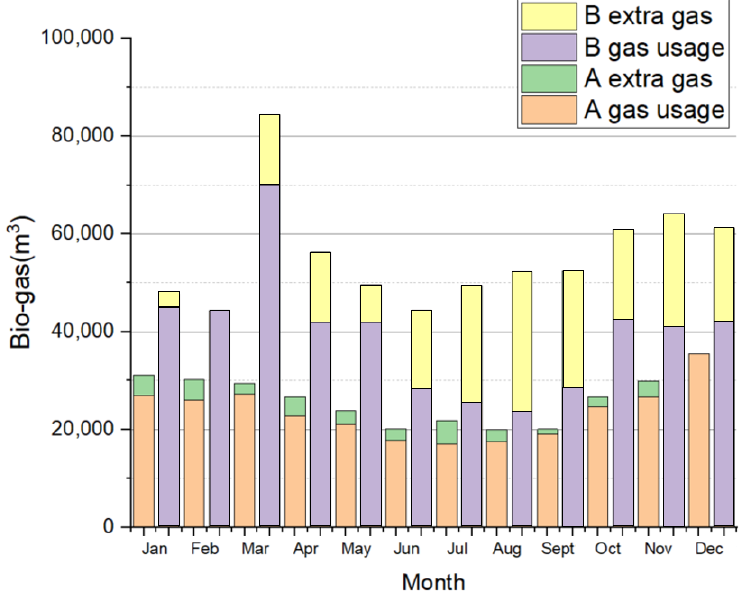
Figure 4. Biogas monthly operation status in Facility A (AD) and Facility B (AcoD).